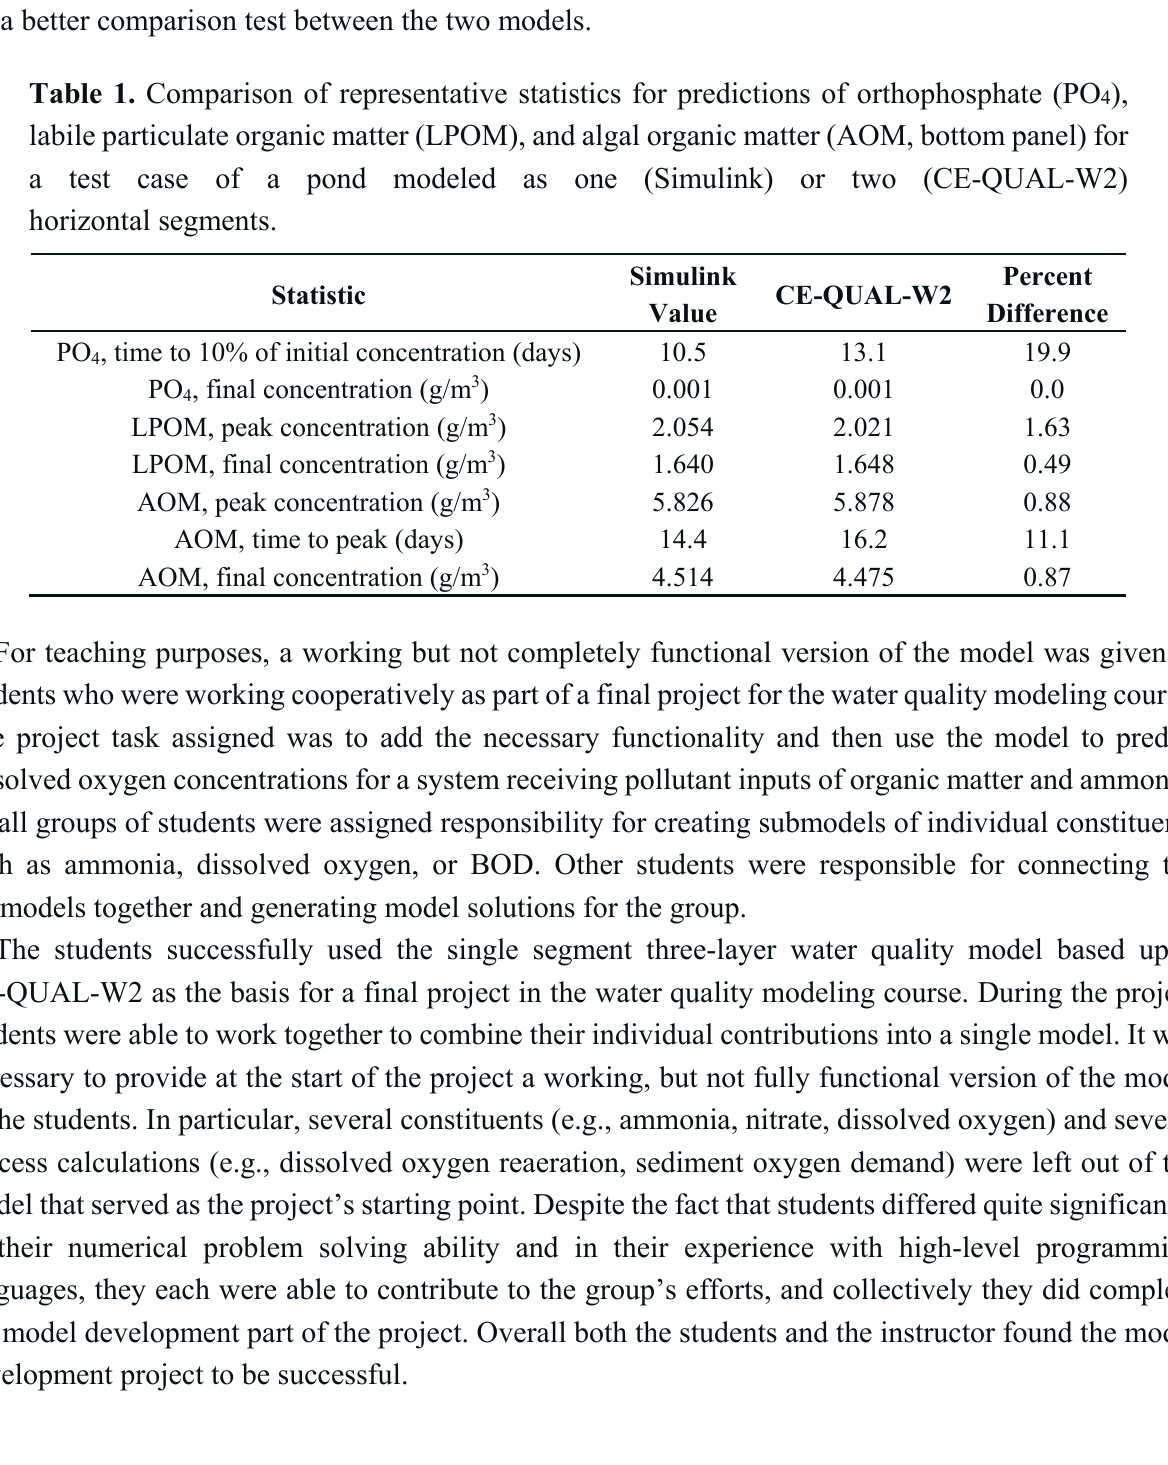
Table 1. Comparison of representative statistics for predictions of orthophosphate (PO 4